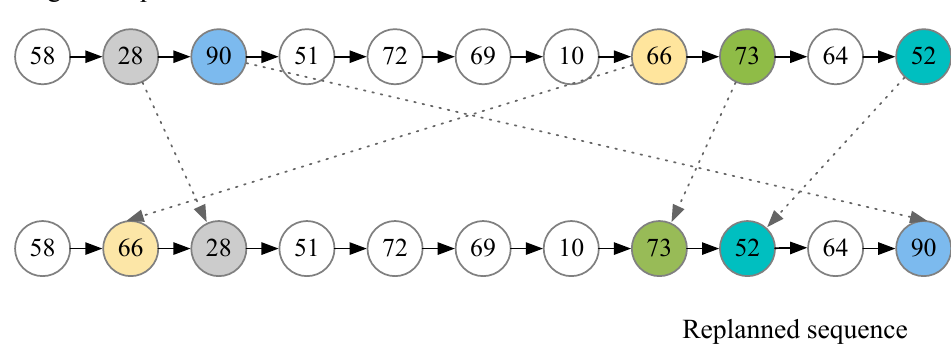
Figure 11. Comparison between the original and replanned solutions for the No. 2 debris removal sequence generated by the MIGA and Ptr-nets+AC algorithm,